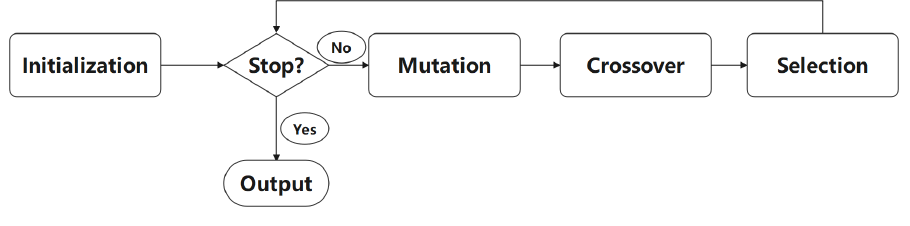
Figure 1. The flowchart of